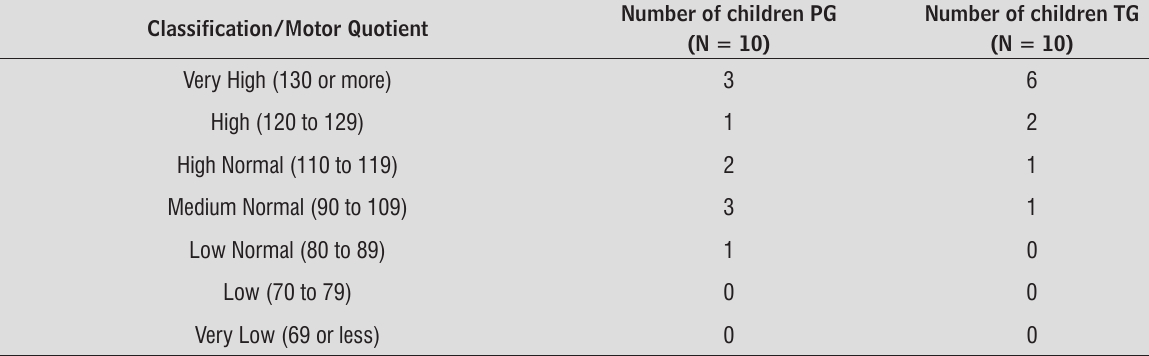
Table 2 - Intergroup comparison of the Classification and Total Motor Quotient (PG and TG) Classification/Motor